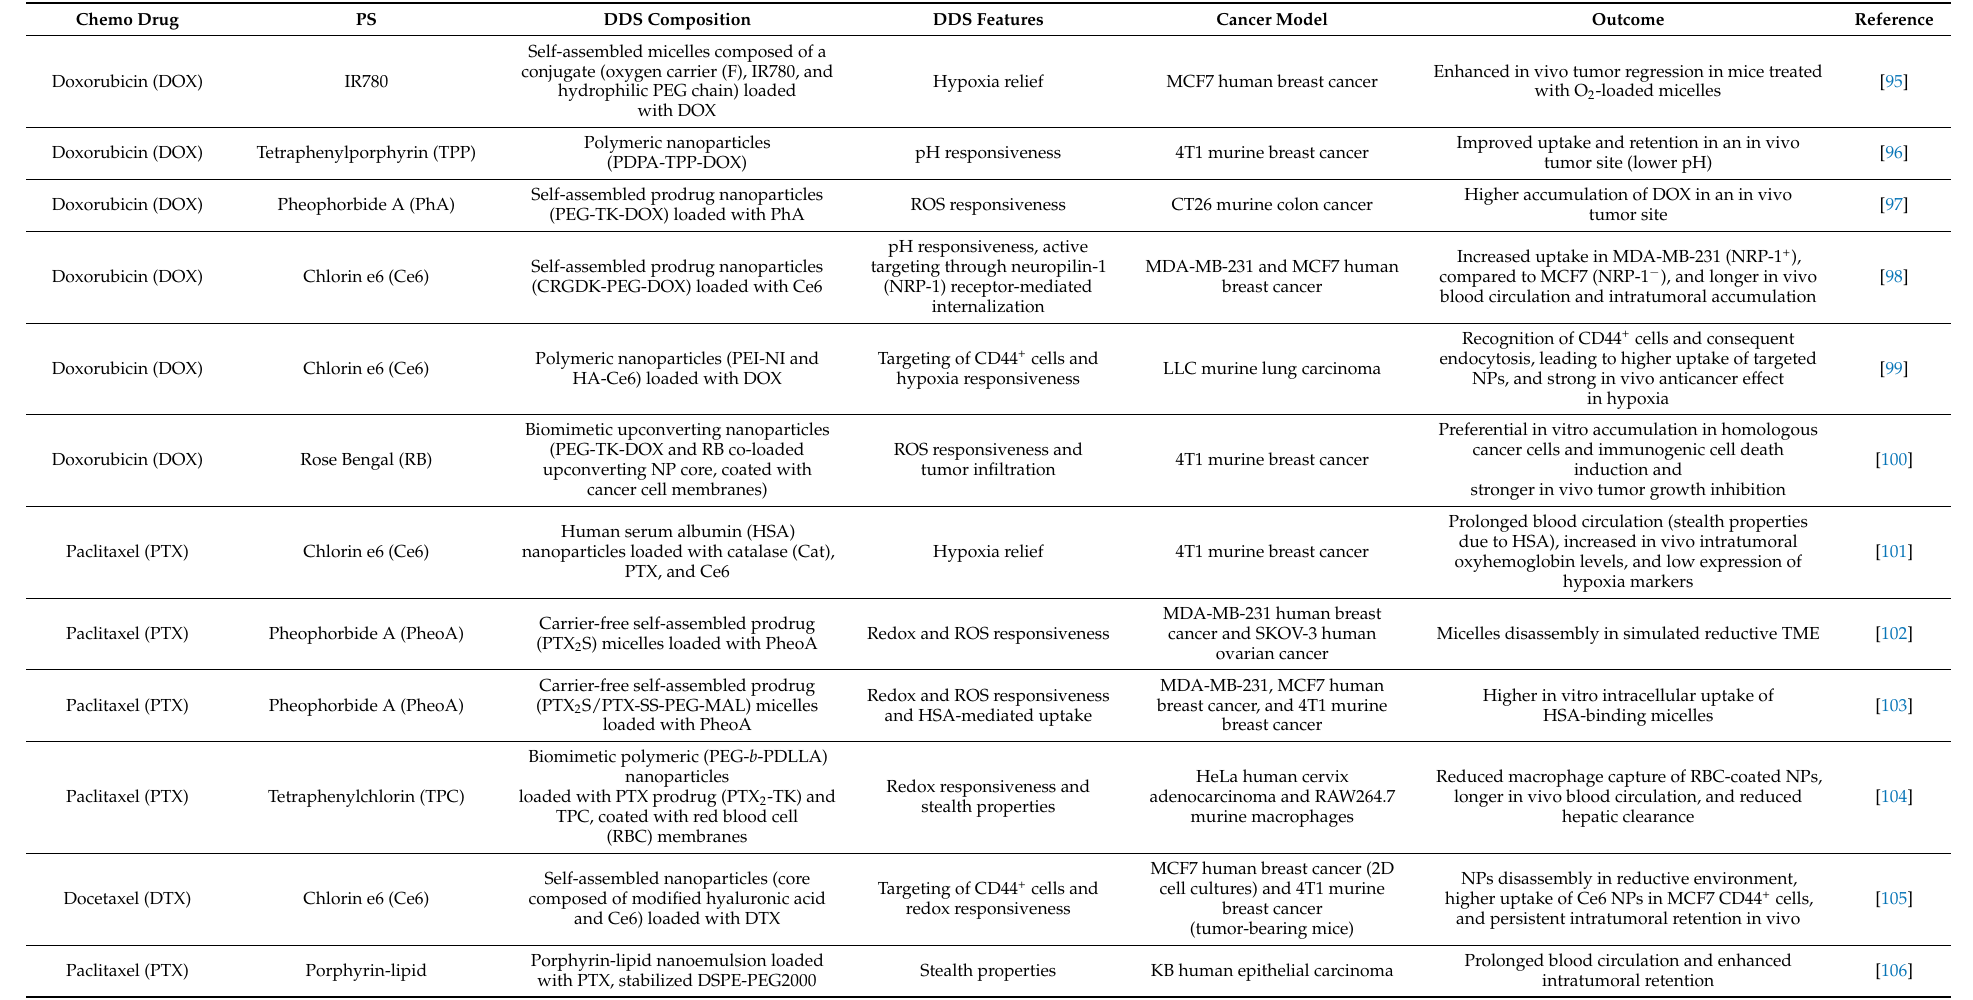
Table 1. Summary of the DDSs developed for the co-delivery of PSs and chemotherapeutics selected from the literature reports spanning from 2017 to 2022 and described in detail in the frame of the present